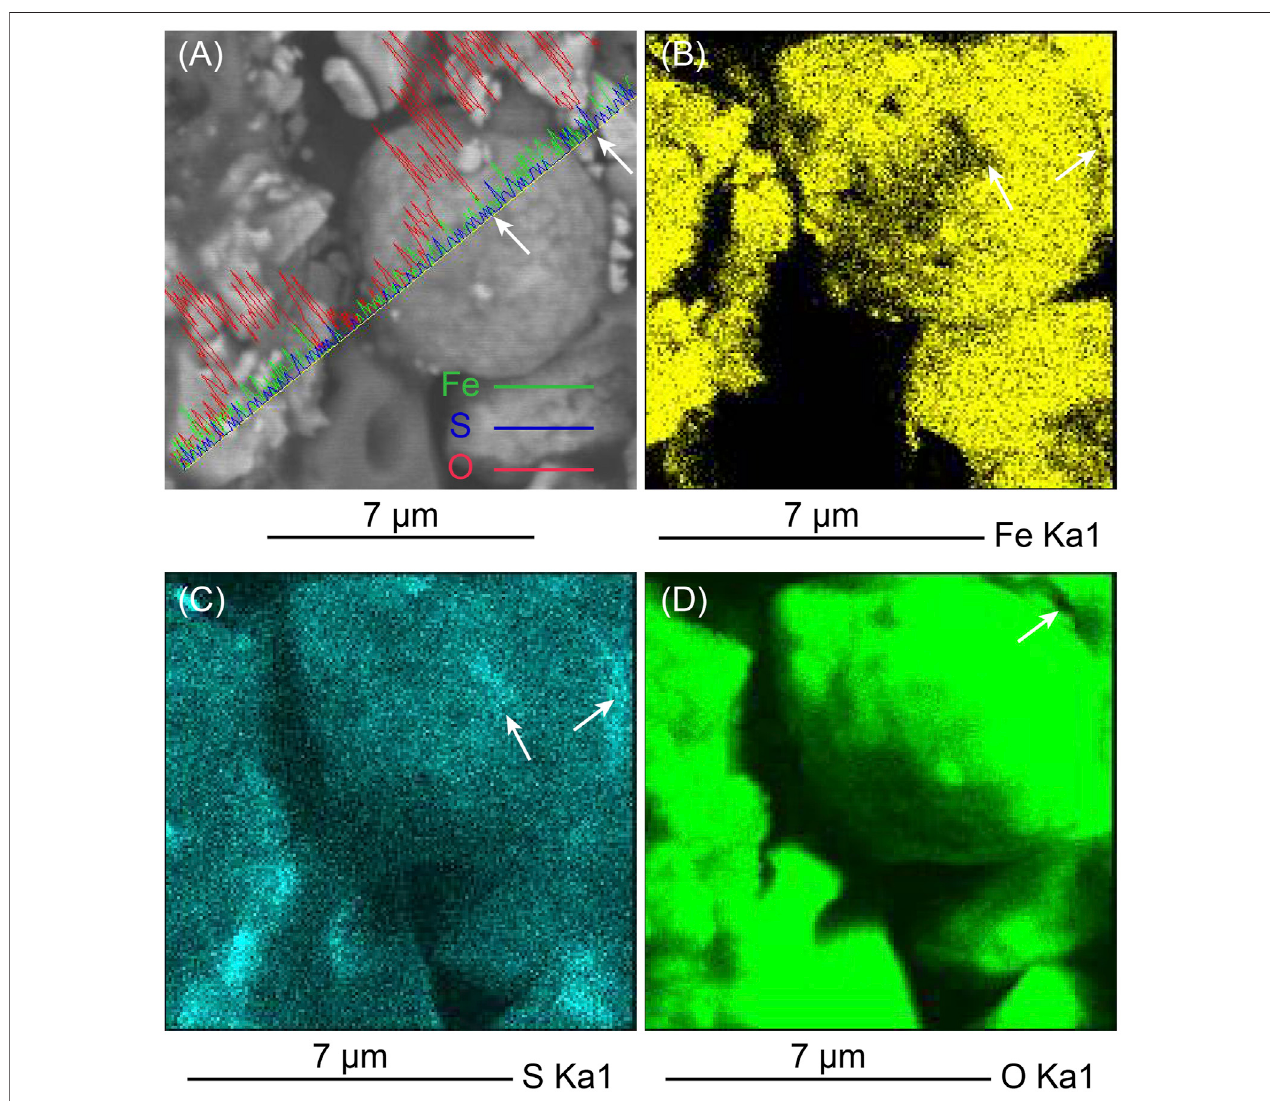
FIGURE 5 | Elemental mapping exhibits elemental compositions and distributions of an iron-oxidized framboid. (A) SEM image of a framboid with line scan by energy spectrum. (B – D) Fe, S, and O elements are scattered in most areas. White arrows show signi fi cant variation in the distributions of Fe, O, and S elements.